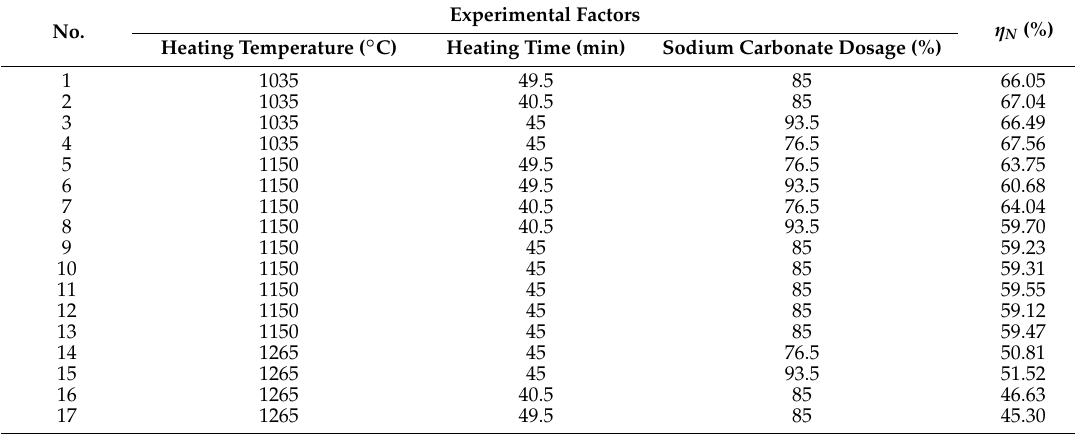
Table 4. Box–Benhken design and experiment results.